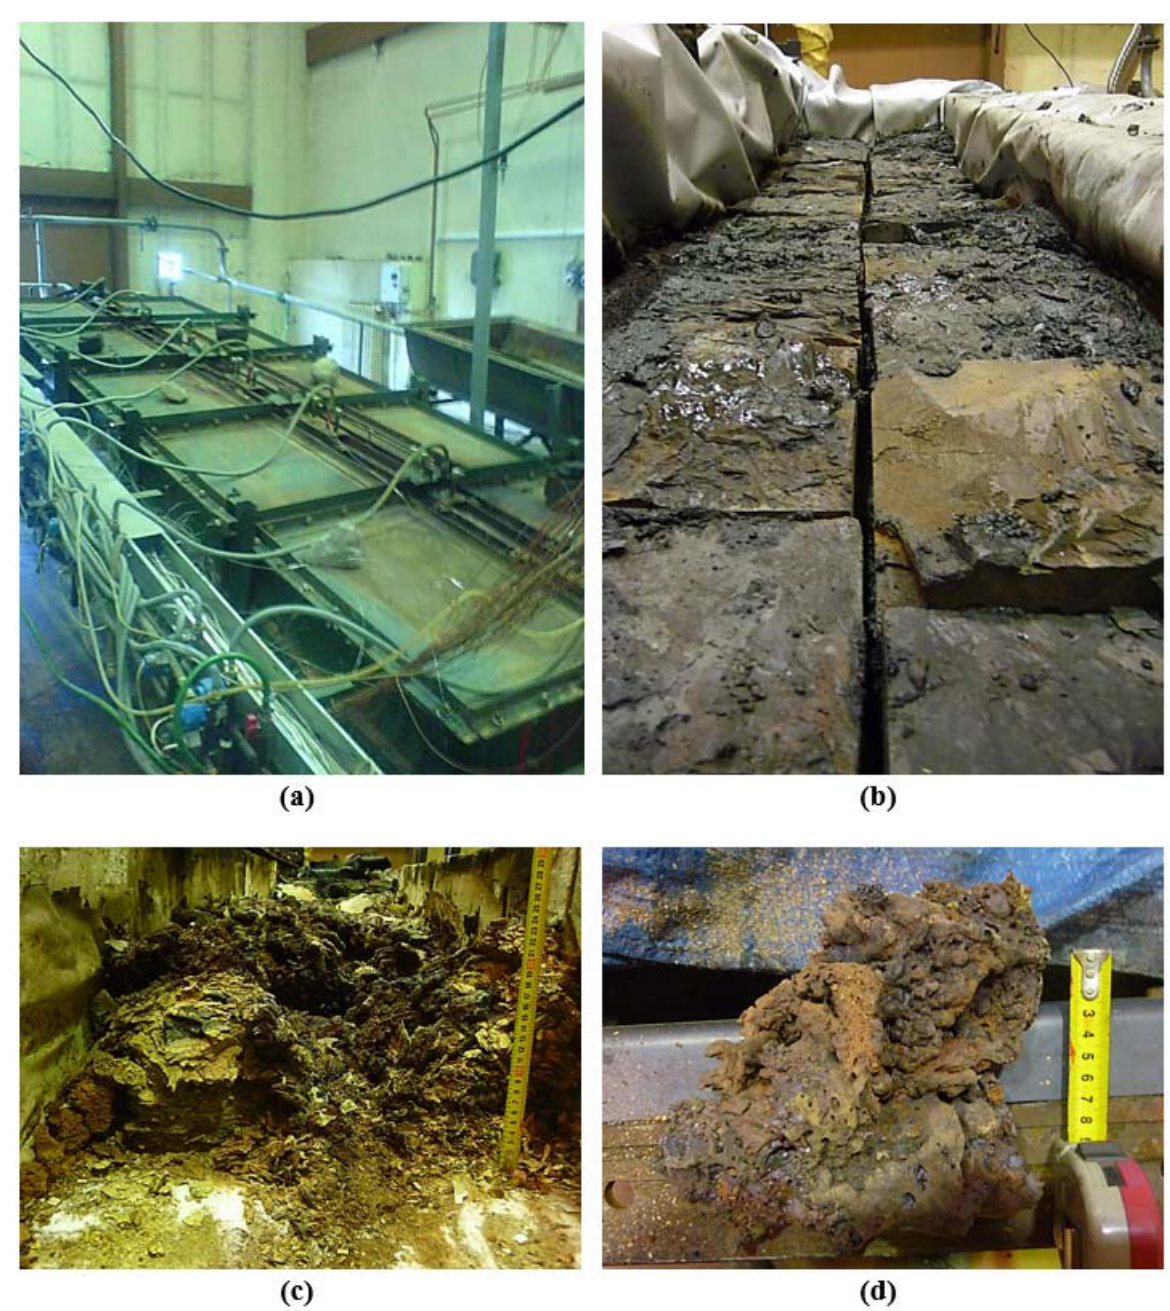
Figure 4. Ex situ reactor: ( a ) closed reactor before experiment start, ( b ) coal bedding, ( c ) gasified coal in reactor, and ( d ) extracted coal specimen.